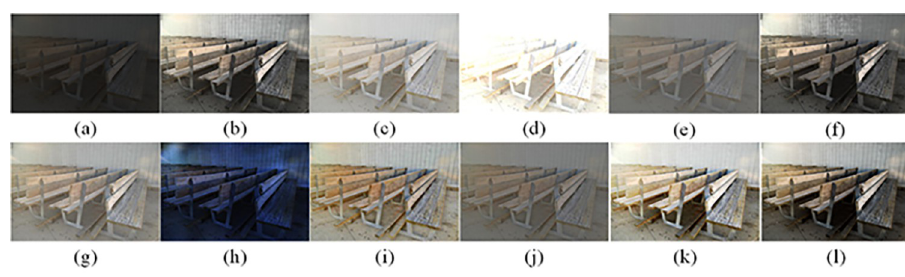
Fig 13. Comparisons of the ten algorithms in enhancing low-light image 3. (a) low-light image (b) AGCWD (c) Al- Ameen (d) BHE2PL (e) BIMEF (f) BPDHE (g) LIME (h) MSRCR (i) NPEA (j) SRIE (k) OURS (l) Normal light image.